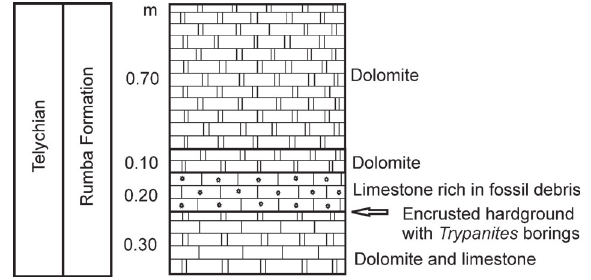
Fig. 2. Section of limestones and dolomites of the Rumba Formation (early Telychian) in the Päärdu outcrop; modified after field notes of Rein